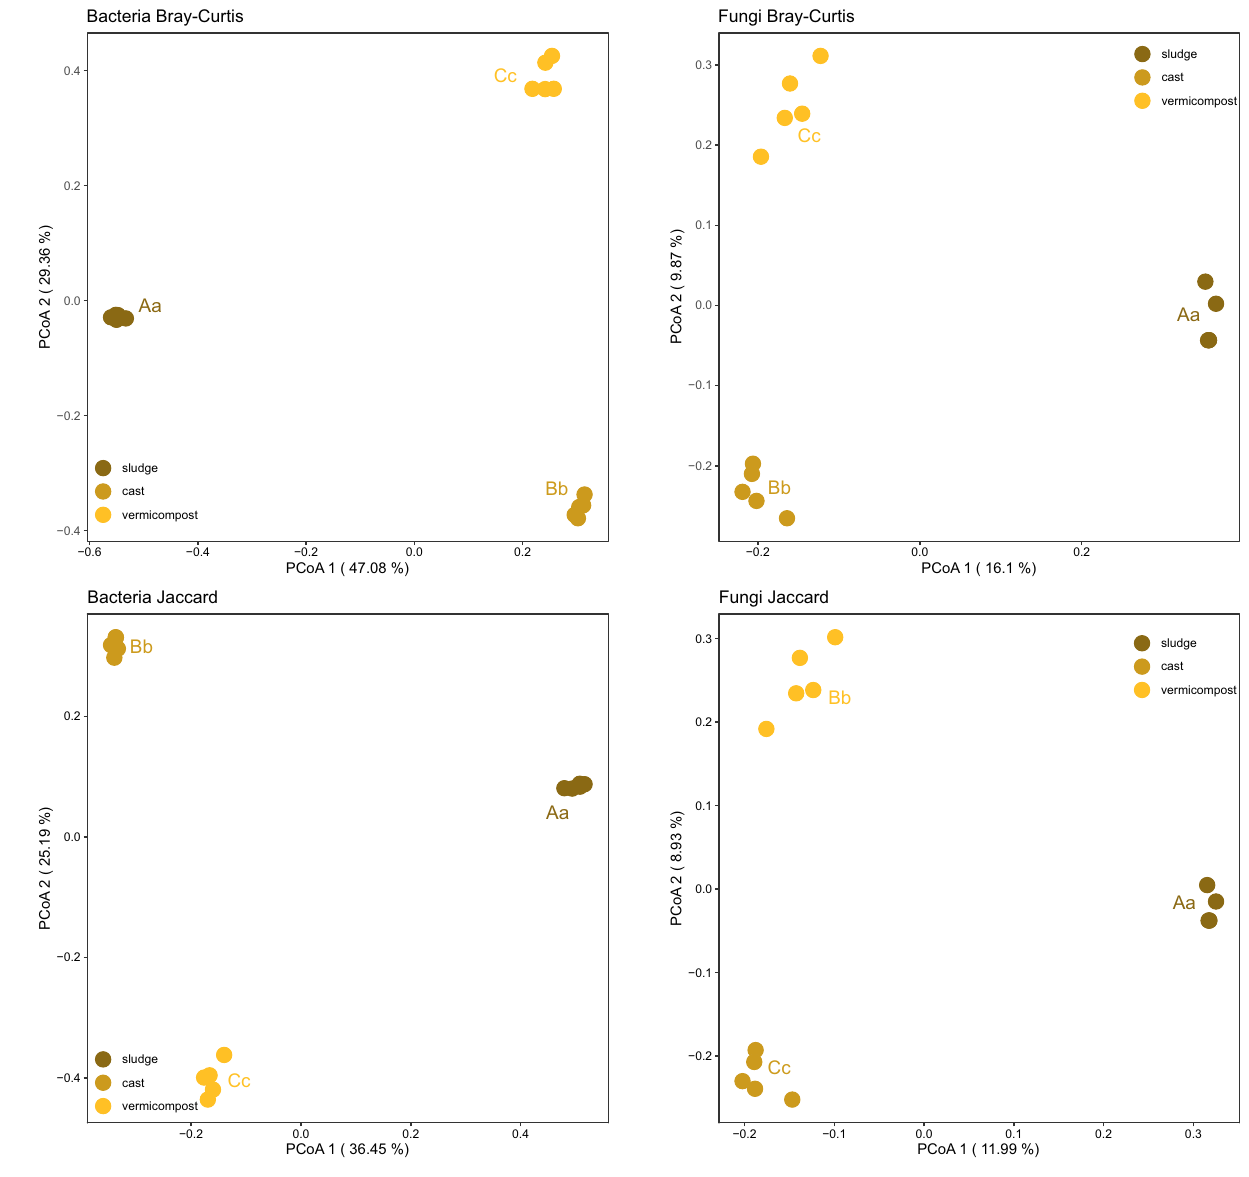
Figure 4. Changes in β-diversity of bacterial and fungal communities during vermicomposting of sewage sludge . Principal coordinate analysis with Bray–Curtis and Jaccard distances. Different capital and lower-case letters indicate significant differences between sewage sludge, fresh earthworm casts and vermicompost in PCoA 1 and PCoA 2 scores respectively (paired Wilcoxon test, FDR